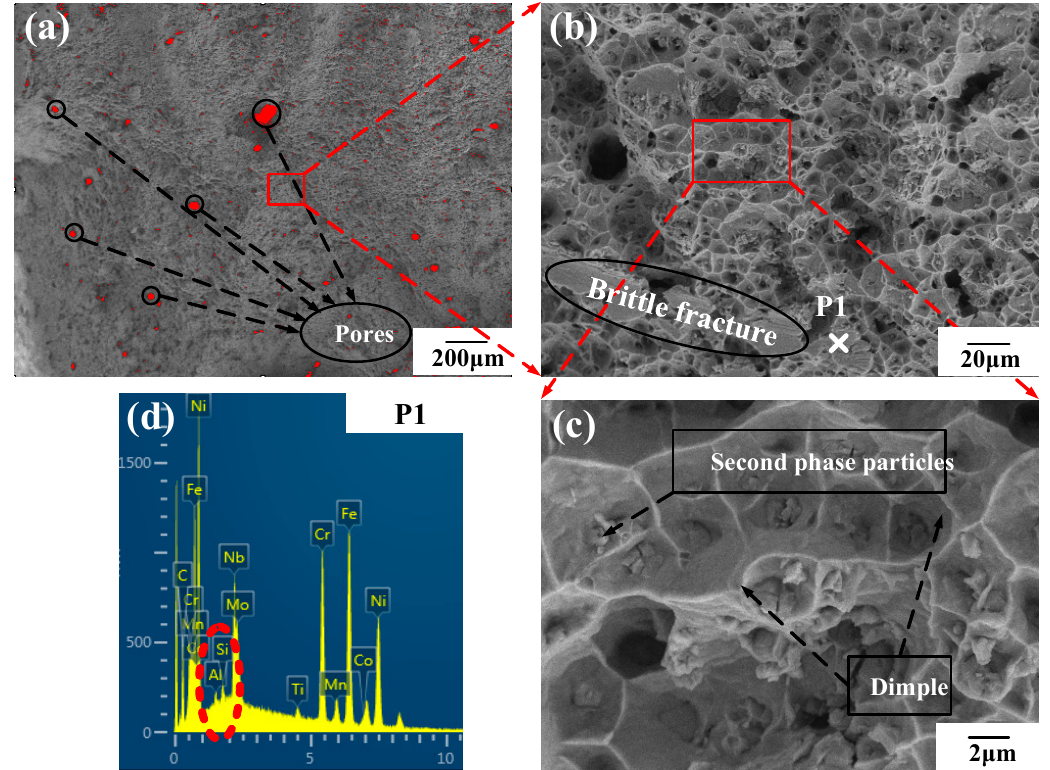
Figure 12. Microscopic fracture morphology and energy spectrum analysis of FGM tensile specimens at room temperature: ( a ) SEM 20×; ( b ) SEM 200×; ( c ) SEM 1000×; ( d ) test point P1 element content.